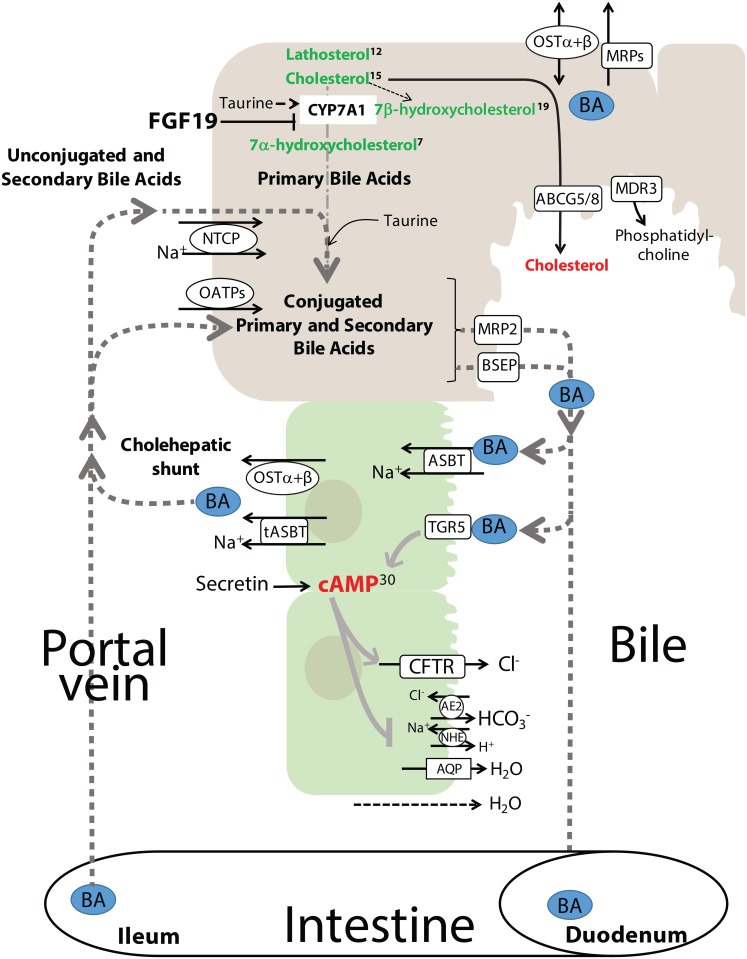
Significant alterations in cholesterol and bile acid metabolism in dogs with gallbladder mucocele formation.Fig depicts synthesis of cholesterol, conversion of cholesterol to primary bile acids, and taurine conjugation of primary and secondary bile acids taking place within an hepatocyte. Compounds identified as secreted into the bile are shown in the context of their interaction with the biliary epithelial cells. Bile acids interact with the biliary epithelium via transport (ASBT) and cell signaling receptors (TGR5). In particular, TGR5 stimulates increases in cAMP resulting in promotion of CFTR-mediated chloride secretion and inhibition of neutral NaCl absorption. Routes for both enterohepatic circulation and cholehepatic shunting of bile acids is shown. Compounds in green font were significantly increased while compounds in red font were significantly decreased in dogs with mucocele formation compared to control dogs. Superscript numbers, when present, indicate rank of the compound as identified by Random Forest analysis as able to distinguish between control dogs and dogs with gallbladder mucocele formation. BA, bile acids.